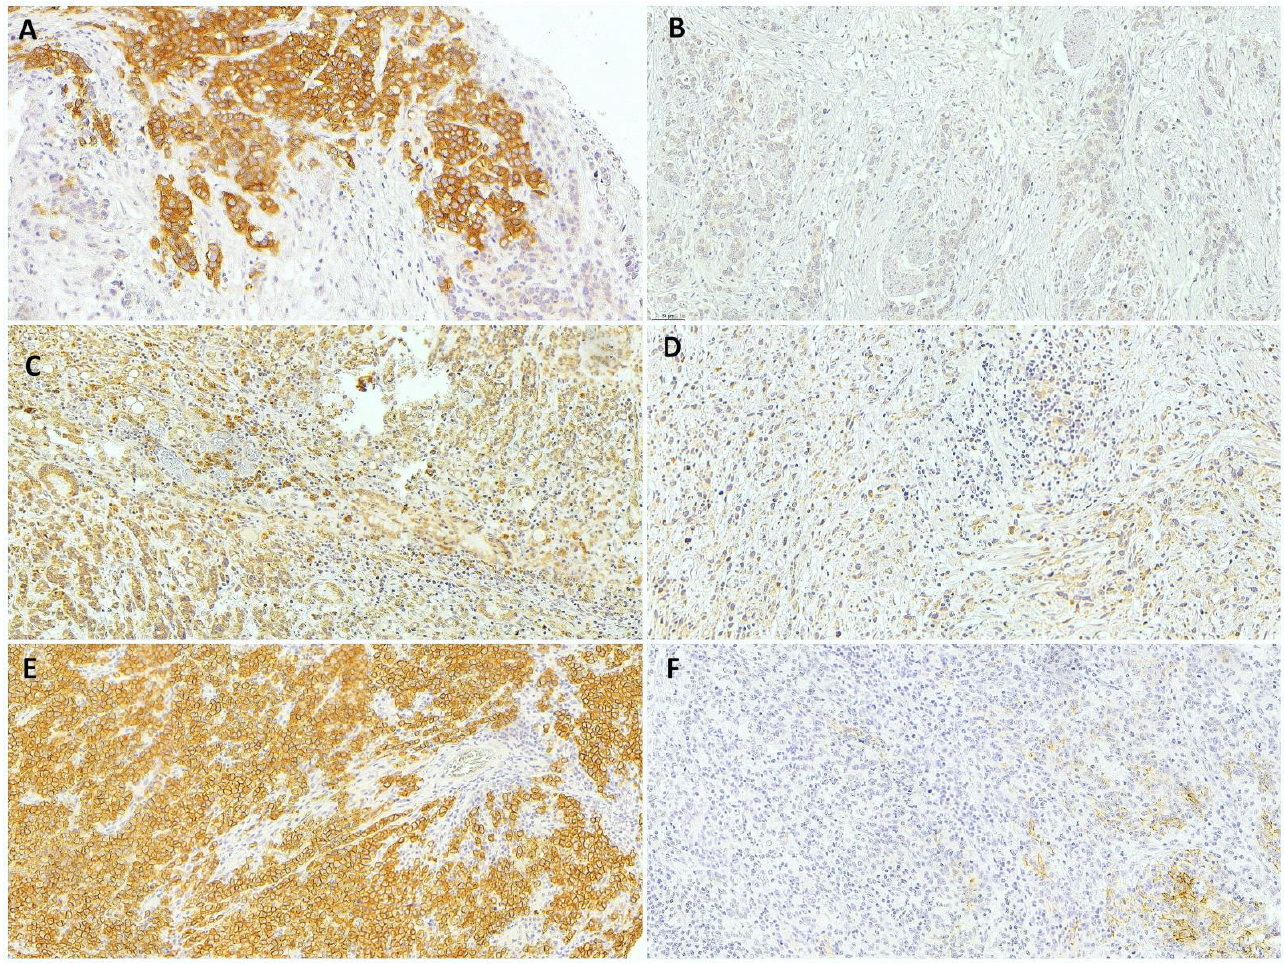
Figure 1. Representative results from immunohistochemical analysis of gastric adenocarcinoma. ( A )